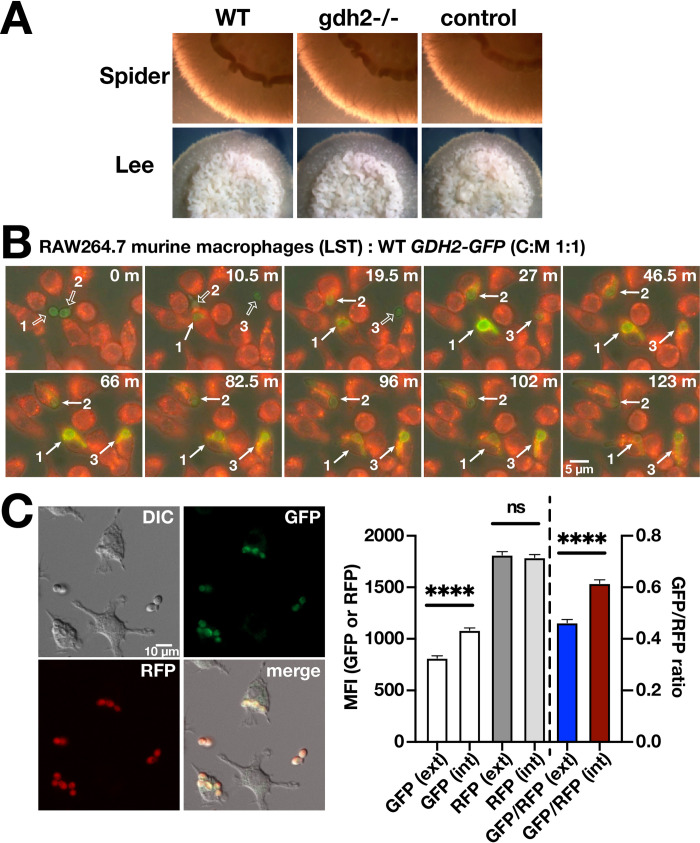
Gdh2 is dispensable for filamentous growth on solid media and is induced in C. albicans cells phagocytized by murine macrophages.(A) Wildtype (WT, SC5314), gdh2-/- (CFG279), and CRISPR control (CFG182) strains, pre-grown in YPD, were washed, resuspended at an OD600 ≈ 1 in water, and 5 μl aliquots were spotted on solid Spider and Lee’s media. Representative colonies were photographed 5 days after incubation at 37°C. CFG273 cells were co-cultured in CO2-independent medium with (B) RAW264.7 macrophages, pre-stained with Lysotracker Red (LST) at MOI of 1:1 (C:M). The co-cultures were followed by live cell imaging. Micrographs were taken at the times indicated (S1 Vid). In each series, three CFG273 cells are marked prior to (open arrows) and after (closed arrows) being phagocytized. (C) Gdh2 expression in phagocytized fungal cells (CFG324) expressing Gdh2-GFP and PADH1-RFP). RAW264.7 macrophages were co-cultured with opsonized CFG324 for 1 h in HBSS prior to measuring GFP and RFP intensities in non- (ext) and phagocytized (int) fungal cells. Results from 3 biological replicates (≥ 100 ext and int cells/replicate) are shown (Ave. ± CI; **** p ≤ 0.0001 by Student t-test).